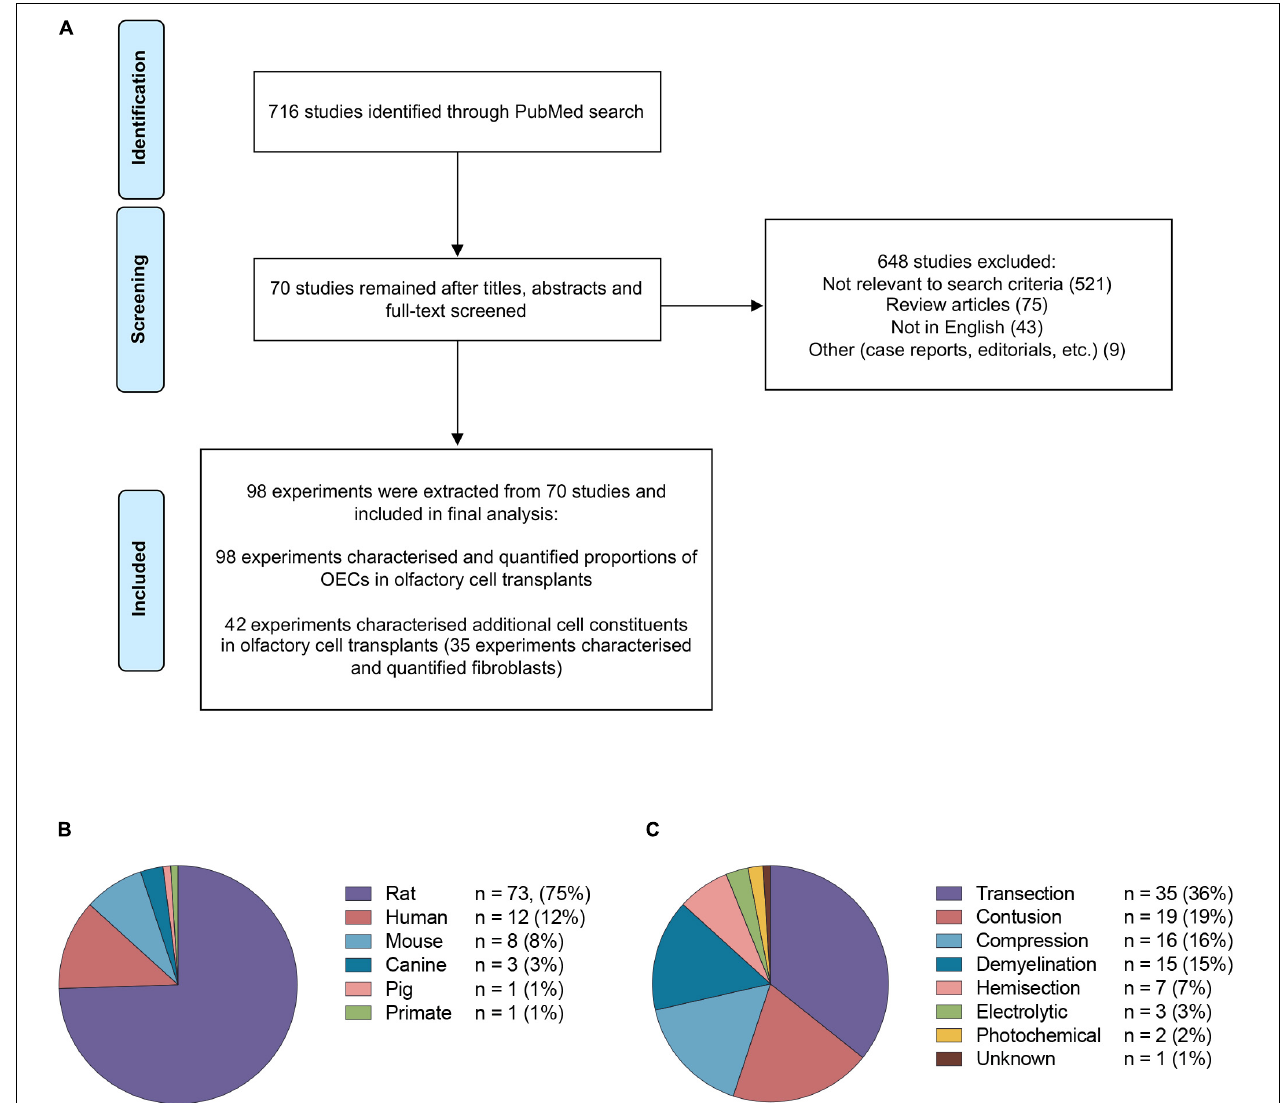
FIGURE 2 | Details of studies included in the analysis. (A) Flow diagram of the study selection process. A total of 70 studies were identified for systematic review. A total of 98 experiments were extracted from the 70 studies based on the inclusion criteria. (B) The species of olfactory cell transplants obtained for transplantation in the studies included in the review ( n = no. of experiments). (C) The types of injury models investigated for transplantation in the studies included in the review ( n = no. of experiments).